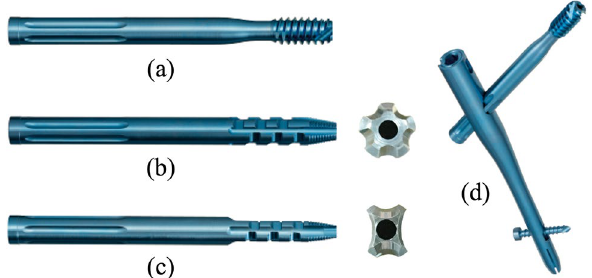
Figure 1. ( a ) Lag Screw component. ( b ) Conventional-Blade component, showing its cross-sectional shape. ( c ) Fid-Blade and its cross-sectional shape (two-face-cut design). Both blades are driven into the femoral head without rotation. ( d ) Magnum